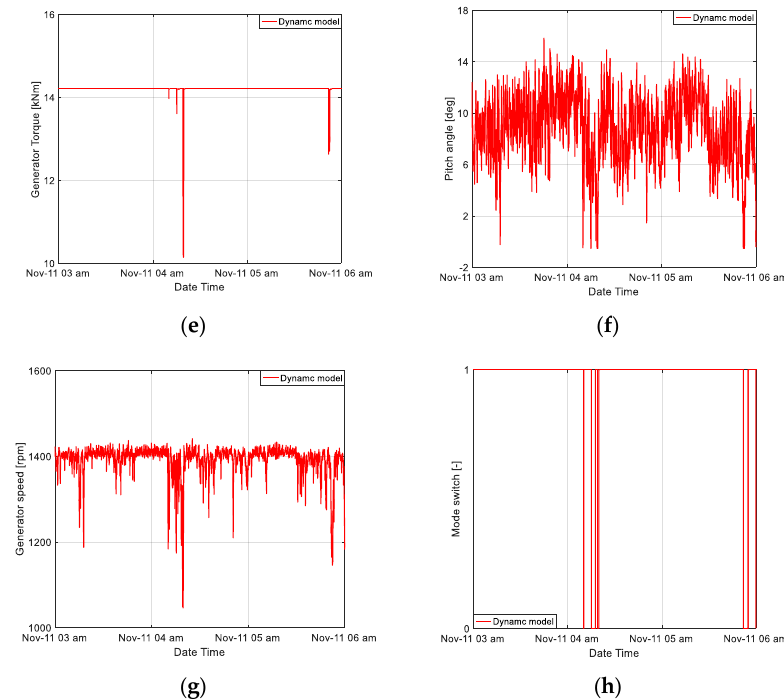
Figure 12. Comparison of the measured and predicted data for 3 h in November ( a ) wind speed, ( b ) wind direction, ( c ) yaw mismatch, ( d ) electrical power, ( e ) generator torque, ( f ) pitch angle, ( g ) generator speed, ( h ) model switch. Table 3. The relative errors of the annual energy production (AEP) by the measured and other models. Normalized Normalized Normalized Dynamic Normalized Dynamic Measured WindSim Model without Yaw Model with Yaw